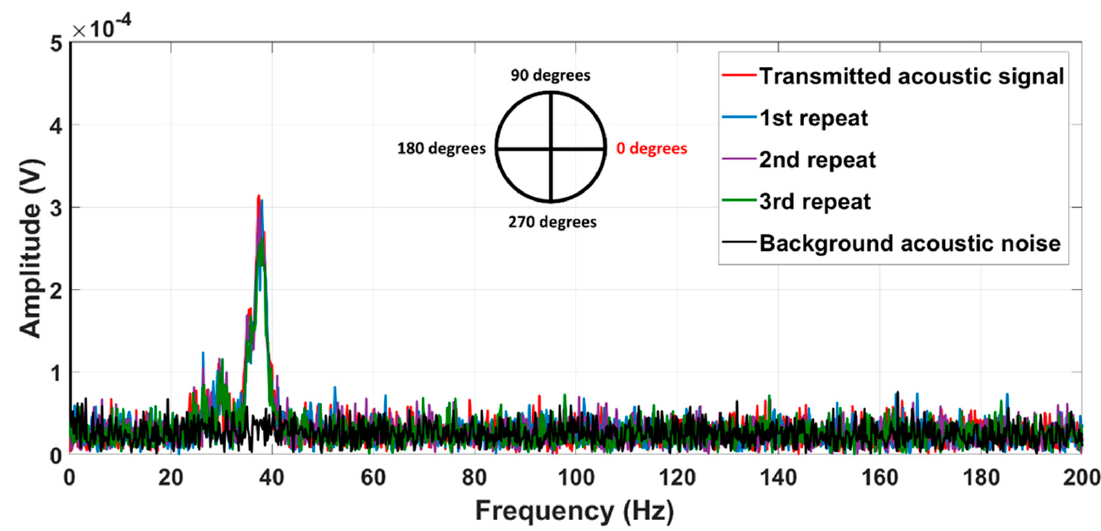
Figure 6. Frequency domain acoustic signal measured at 4 m from the acoustic transmitter and at 0 degrees around the pipe circumference.